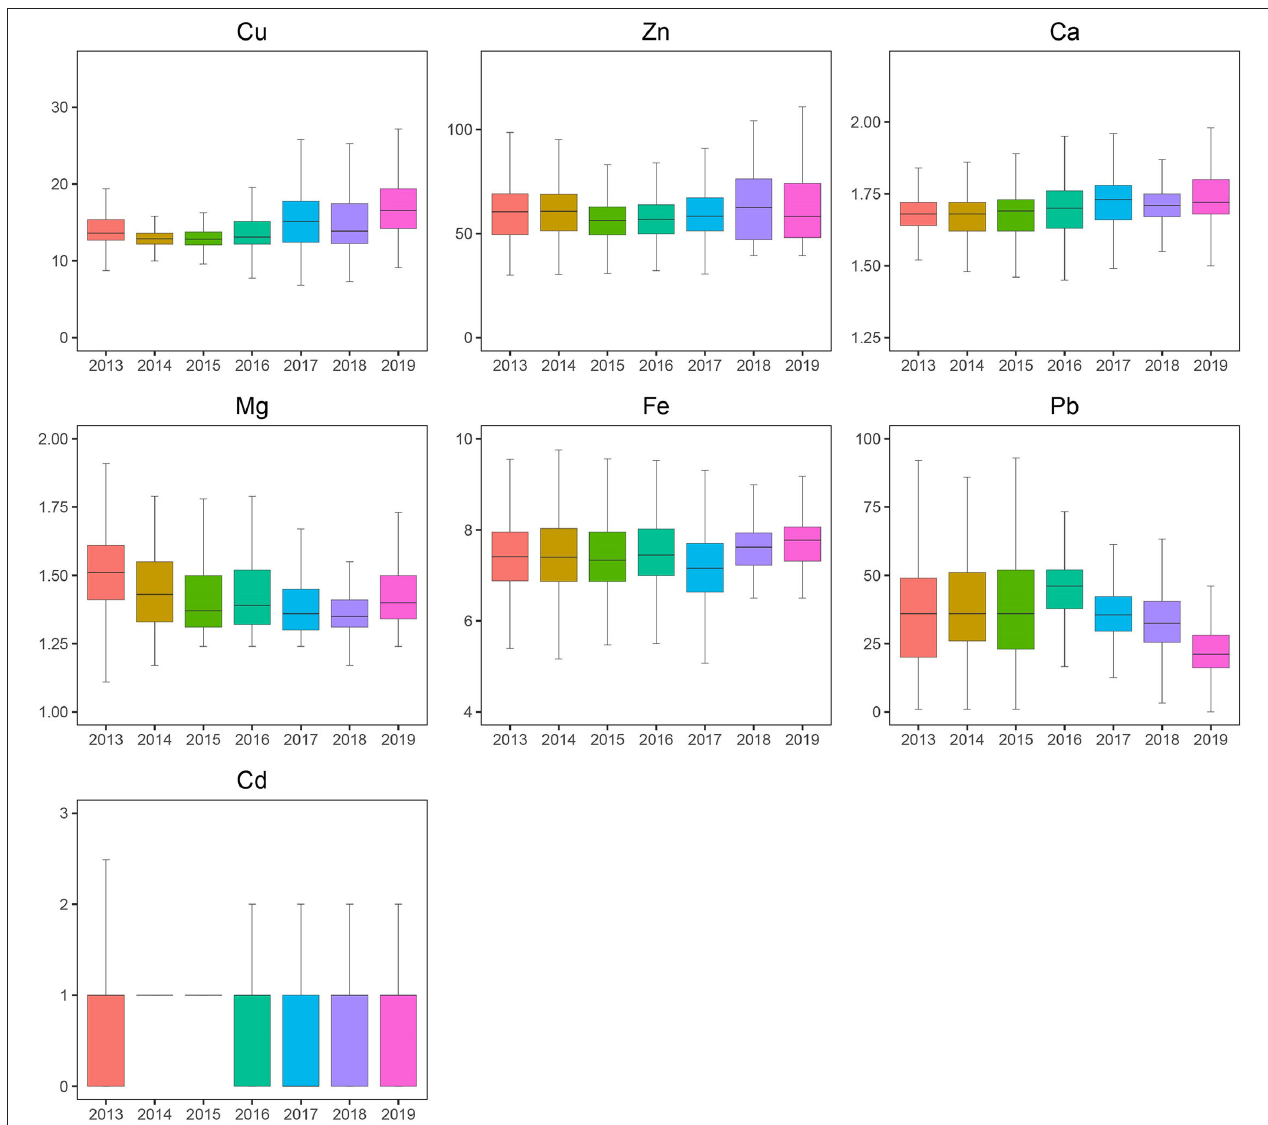
FIGURE 2 | Blood levels of toxic and essential elements in the children aged 0 ∼ 14 years by year, 2013–2019. The boxplot showed the median values of elements and their percentile ranges.